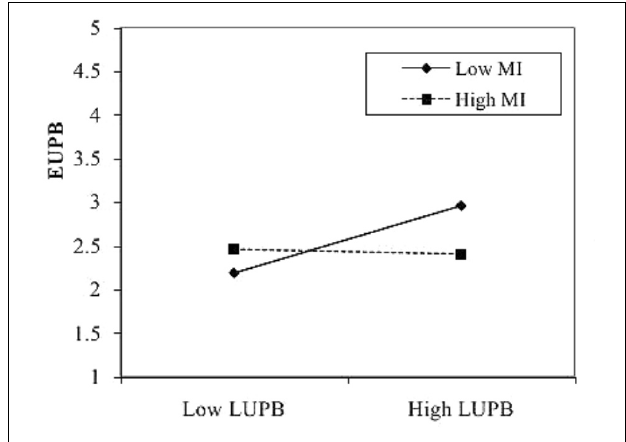
FIGURE 2 | Interaction between LUPB and moral identity on EUPB. LUPB, leaders’ unethical pro-organizational behavior. EUPB, employees’ unethical pro-organizational behavior; MI, moral